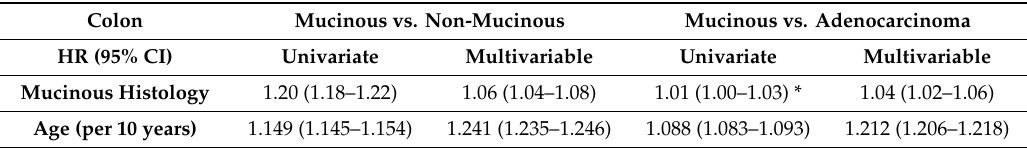
Table 2. Derived univariate and multivariable Cox-proportional hazard ratios (HR) of mortality for colon